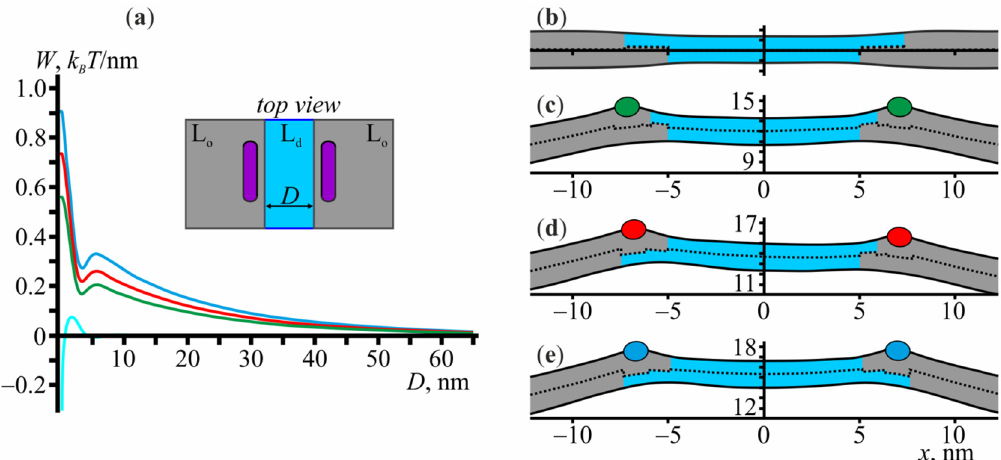
Figure 4. The effect of amphipathic peptides on the interaction of L o domain boundaries. ( a ) The dependence of elastic energy of the membrane on the distance D between L o domain boundaries in the absence (cyan curve) and presence (green, red, blue curves) of amphipathic peptides. ( b – e ) The calculated shapes of the membrane for a distance D = 10 nm between domain boundaries in the absence of the peptides ( b ) and the presence of the peptides at different configurations of the boundaries ( c – e ). In panels ( c – e ), the color of the peptide (shown as green ( c ), red ( d ), or blue ( e ) ellipses) corresponds to green, red and blue curves in panel ( a ), respectively.